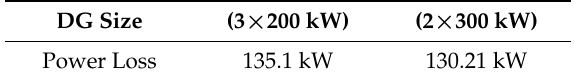
Table 7. System power loss allocating same power with different